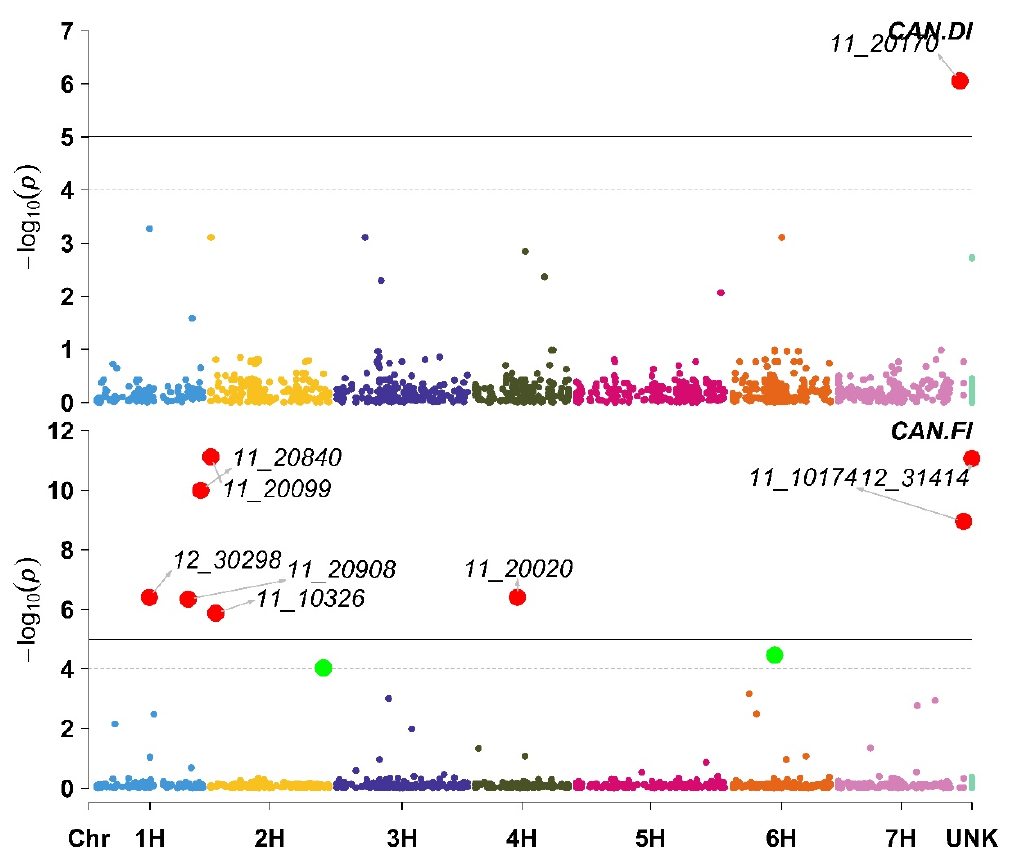
Figure 2. Manhattan plot displaying the results of the genome-wide association scan (red dots annotated dots refer to significant markers or markers with −log10 (p) more than 5, while the green dots refer to non-significant markers but have −log10 (p) between 4 and 5) for the Canopy Temperature (CAN) using 426 barley lines under Deficit Irrigation (CAN.DI, upper plot) and Full Irrigation (CAN.FI, lower plot).